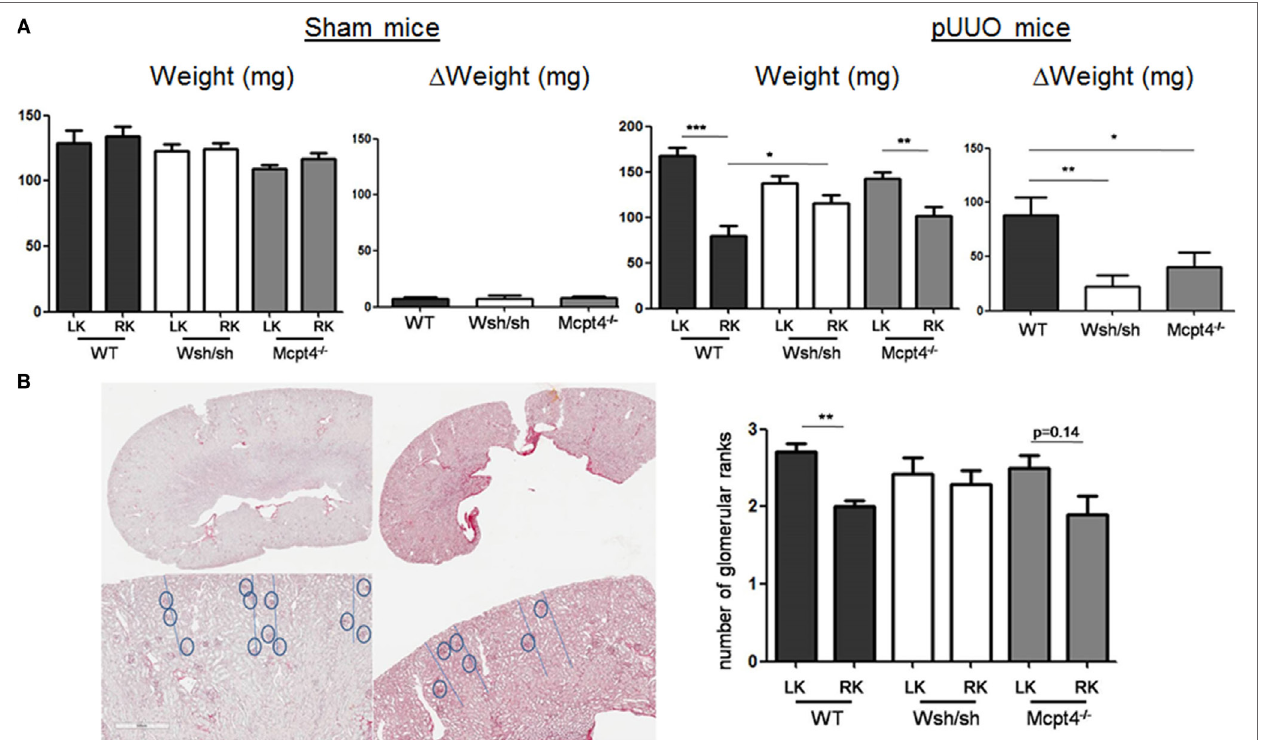
FigUre 3 | evaluation of renal pathology after partial unilateral ureteral obstruction (pUUO) by postmortem kidney weight and nephrogenesis analysis . (a) Evaluation of kidney weight following pUUO. The left panel shows the quantification of weight for right kidneys (RKs) and left kidneys (LKs) of indicated sham-operated mice at D75 post-surgery [ n = 4 for wild type (WT), 5 for mast cell (MC), and 5 for MCPT4-deficient mice]. The right panel shows the quantification of weight for RK and LK of indicated pUUO operated mice at D75 post-surgery ( n = 17 for WT, 12 for MC, and 20 for MCPT4-deficient mice). Delta weight ( Δ W) denotes the difference in weight between hypertrophic LK and hypotrophic RK for each mouse strain of mice. Data are the mean ± SEM of indicated numbers of mice (as above) (* p ≤ 0.05, ** p ≤ 0.01, and *** p ≤ 0.001). (B) Left panel shows histological images of LK and RK (Sirius Red stain) from WT mice. The upper row shows the entire slice of kidney, the bottom row shows a magnified part of the cortex ( × 4) to illustrate the decrease in glomerular ranks for RK compared to LK (gray dashed line). The right panel shows the corresponding quantification of glomerular ranks in WT, MC-, and MCPT4-deficient mice. Data are the mean ± SEM of indicated numbers of mice [see (a) ], ** p ≤